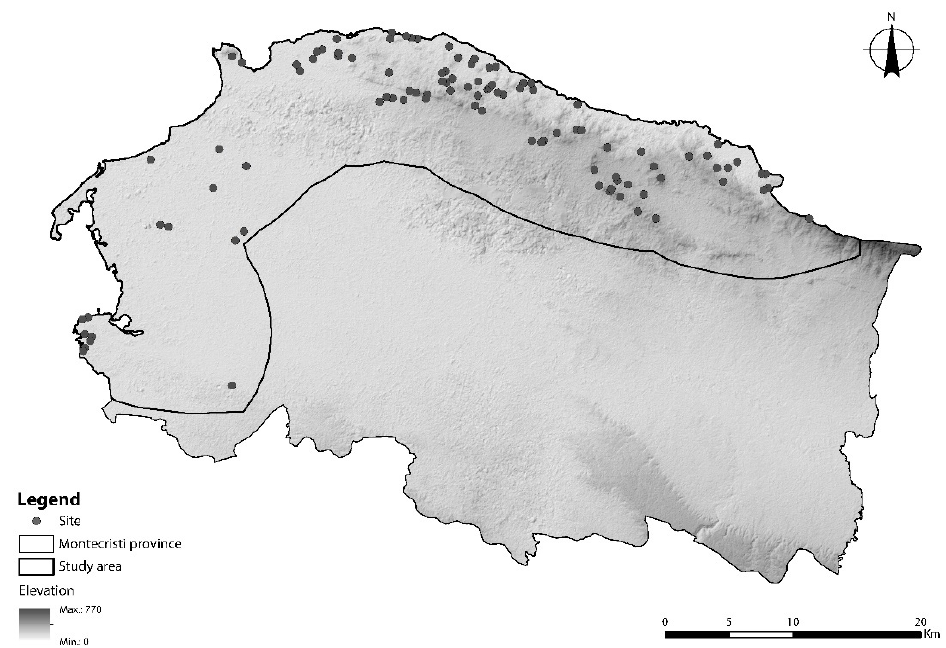
Figure 2. Registered archaeological sites in the coast of Montecristi, Dominican Republic.